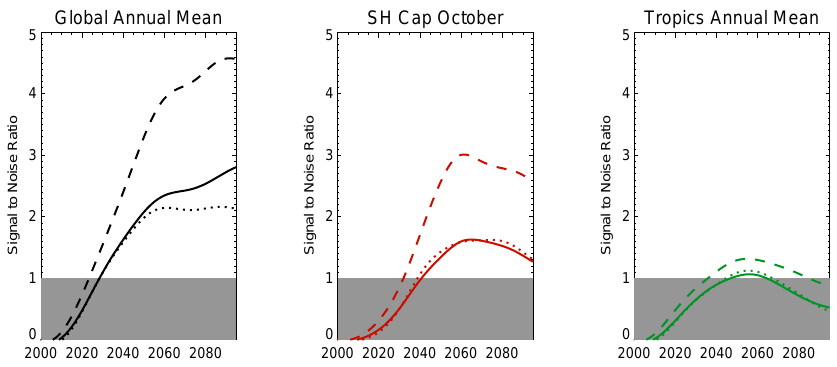
Fig. 4. Estimated signal-to-noise ratio (S/N, see text for details) of the change in total-ozone column amounts relative to the multi-model mean amount in 2000. Solid lines show estimates which include model uncertainty, internal variability and scenario uncertainty from four model integrations run with SRES scenarios. Dotted lines show estimates which include model uncertainty, internal variability and scenario uncertainty from three model integrations of CAM3.5 run with RCP scenarios. Dashed lines show estimates which exclude scenario uncertainty. Different coloured lines indicate averages over different geographical regions and seasons. Black lines show the global and annual average, red lines show the springtime SH polar cap (60–90 ◦ S, October) and the green lines show the tropical region (25 ◦ N–25 ◦ S), annual average). Grey shading highlights the region with S/N less than 1.